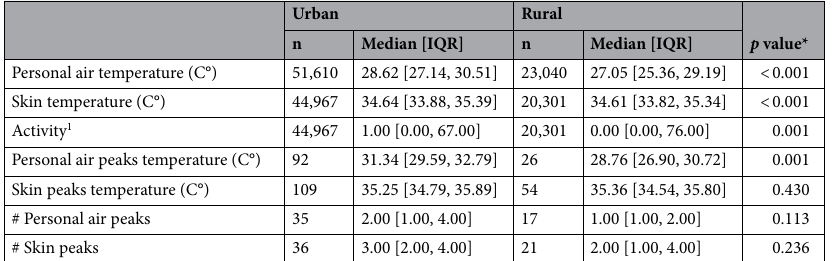
Table 2. Wearable sensor-based air and skin temperature diurnal variation, number of peaks and activity measurements stratified by setting (urban or rural). 1 Activity based on skin temperature sensor. *Based on the Wilcoxon rank sum